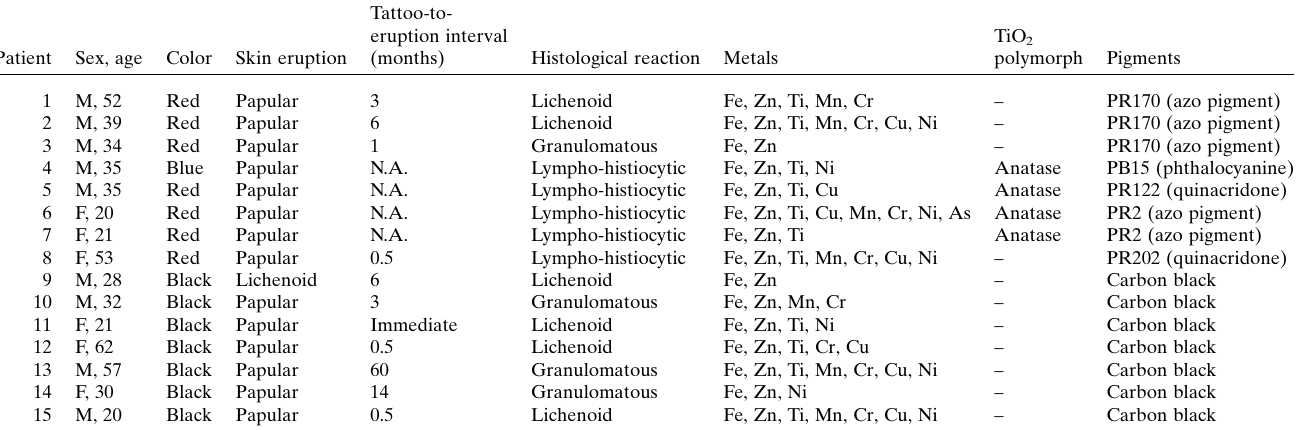
Tattoo-to- eruption